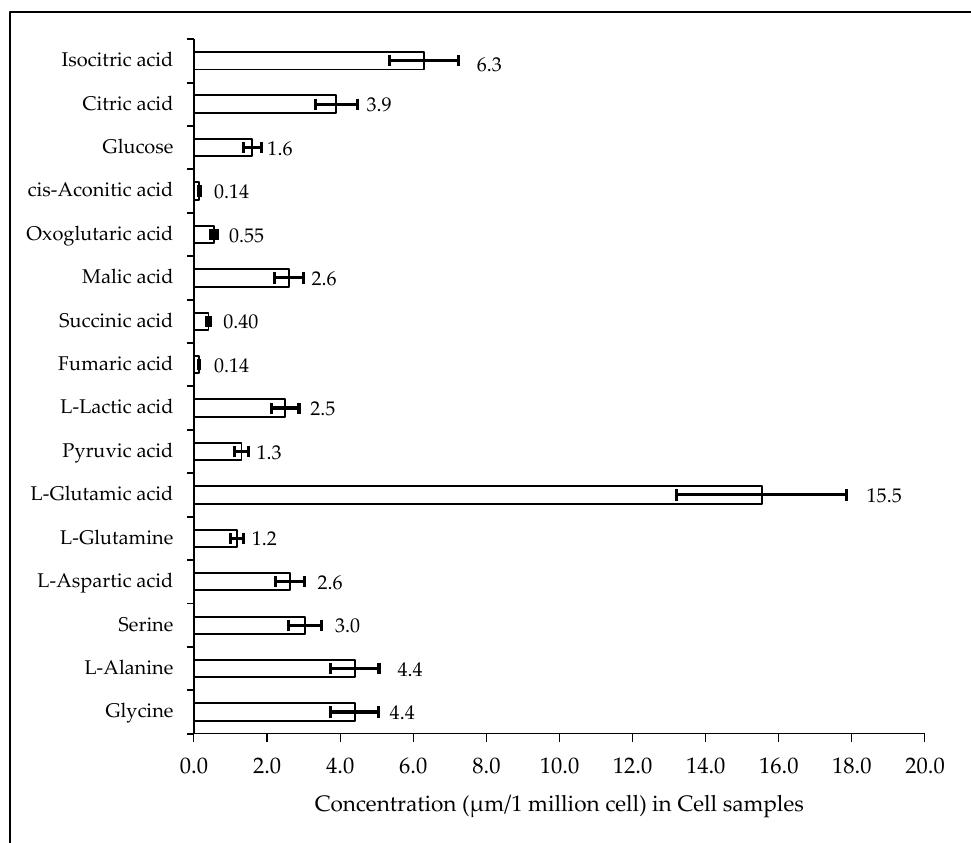
Figure 4. Measure of TCA cycle intermediates (Glycine, Alanine, and Serine) concentration in National Institute of Standards Technology, Standard Reference Material, Plasma 1950. The error bar is in standard deviation. Calculated value is the concentration obtained by injecting six replicate NIST SRM 1950 samples by this method and the reference value is the value given in the certificate of NIST SRM 1950.